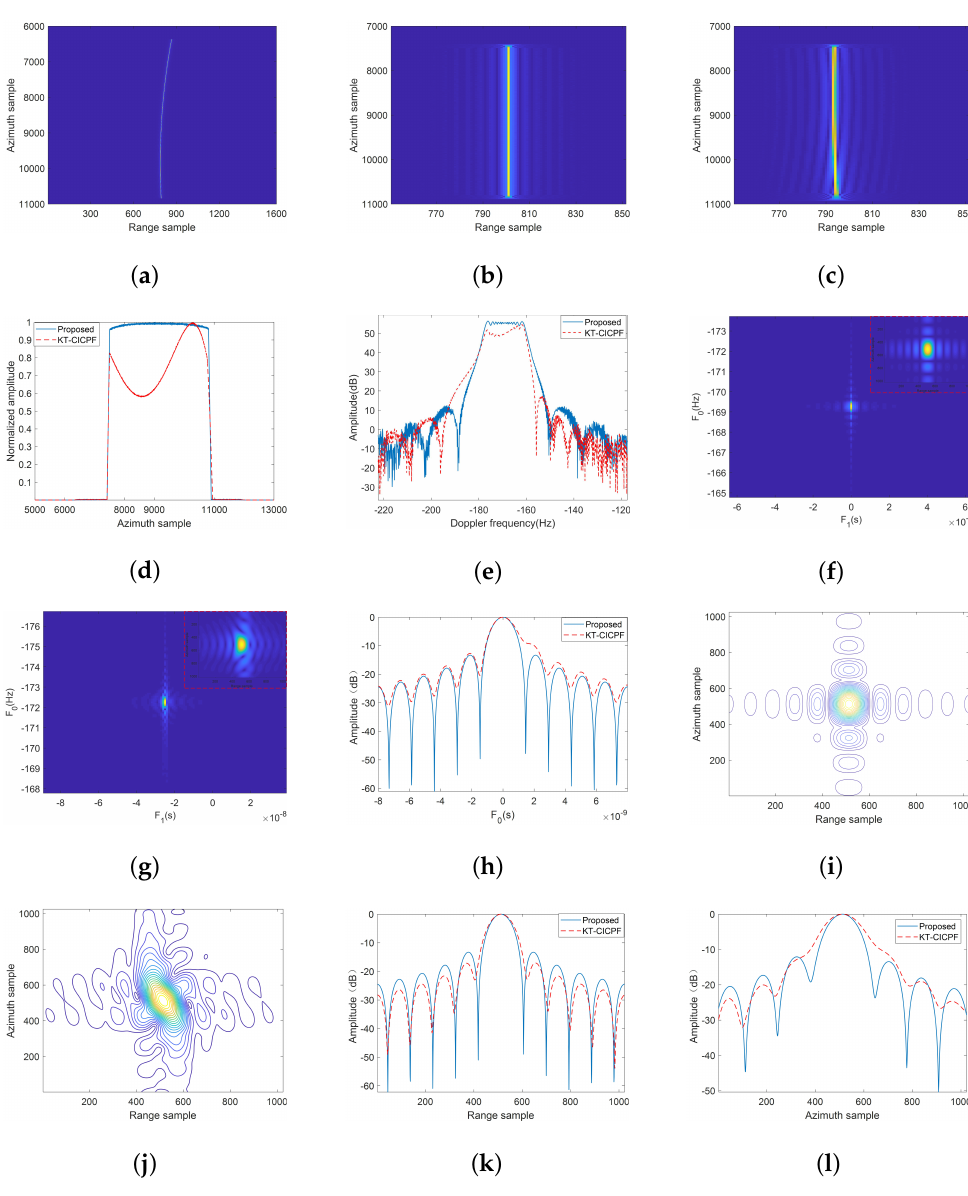
Figure 5. The focused images of point target. ( a ) Range compression. ( b ) The proposed DCCF. ( c ) DCCF constructed by KT-CICPF. ( d ) Peak signal extracted by DCCF. ( e ) Spectrum of peak signal. ( f ) F 0 – F 1 parametric plane by proposed method. ( g ) F 0 – F 1 1parametric plane by KT-CICPF. ( h ) F 0 slice. ( i ) Image of the proposed method (64 × upsampling). ( j ) Image of the KT-CICPF method (64 ×